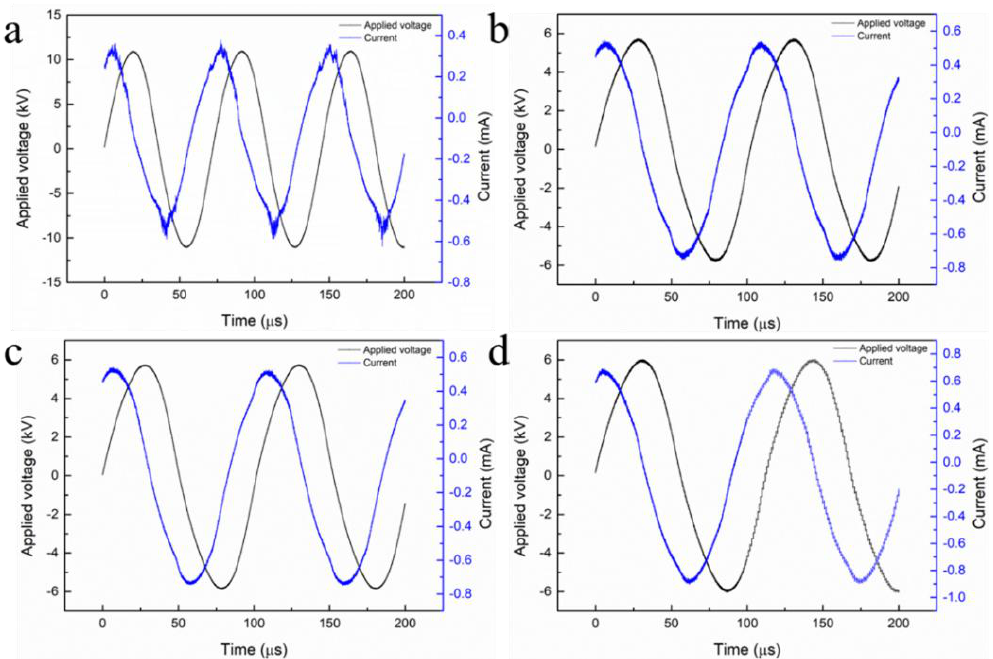
Figure 4. Discharge characteristics of CO 2 in the DBD reactor without or with filling foam metals: ( a ) Without packing; ( b ) Foam Fe; ( c ) Foam Al; ( d ) Foam Ti.